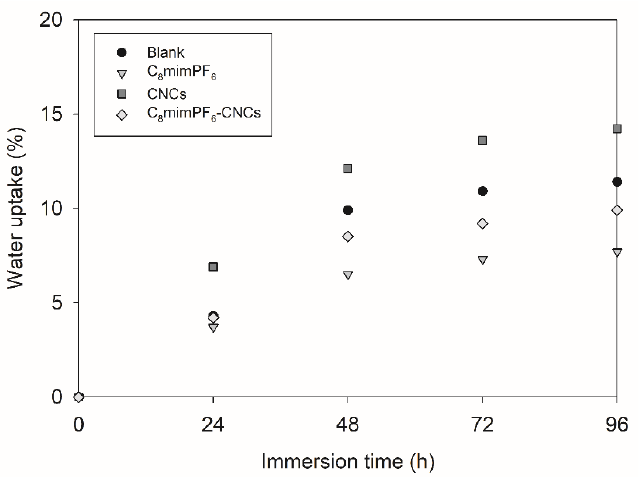
Figure 5. Water uptake of different coated samples immersed for up to 96 h.